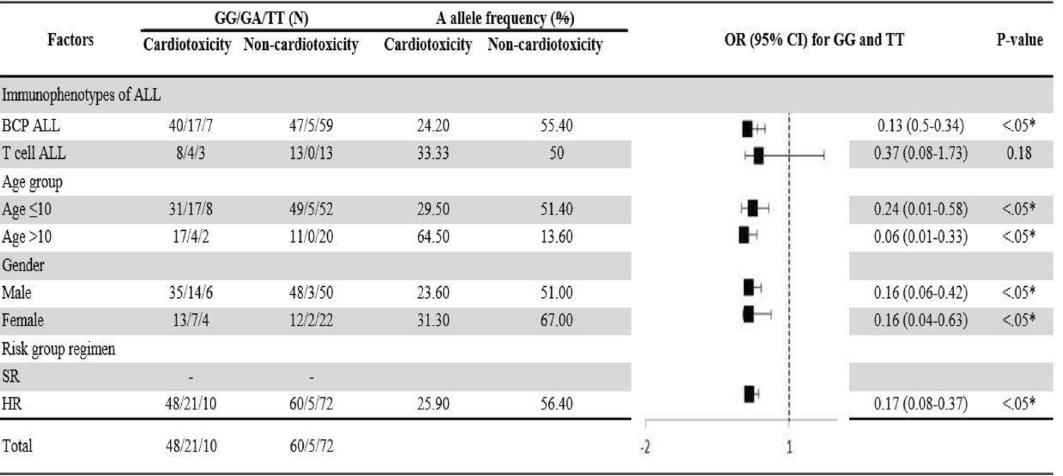
Figure 5. Adjusted association between ABCG2 (rs2231142) genotypes and risk of